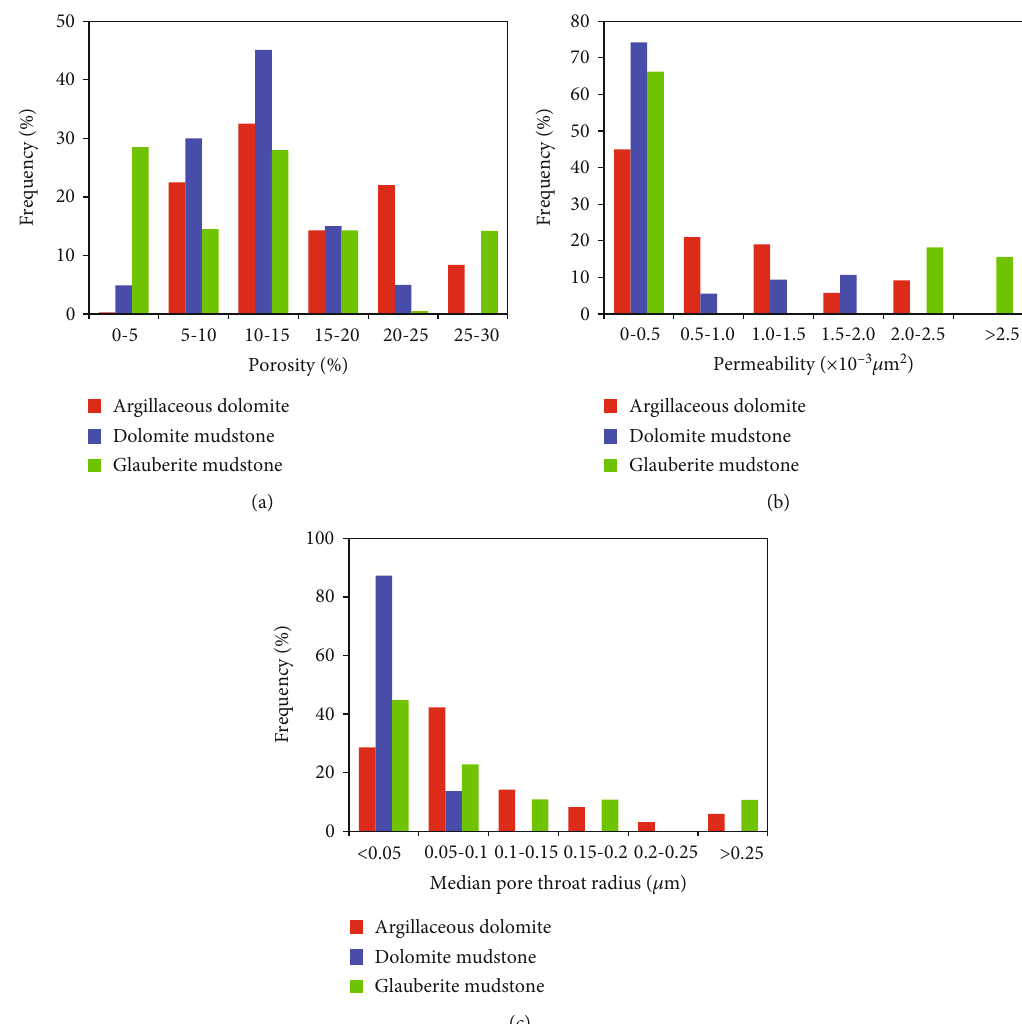
Figure 2: Spectrum statistics results of porosity and permeability of di ff erent